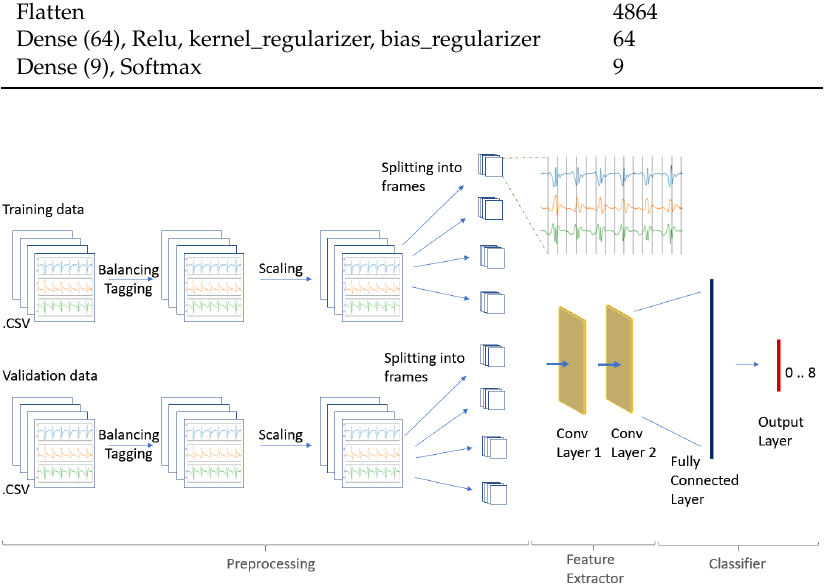
Figure 3. Overview preprocessing, feature extraction and